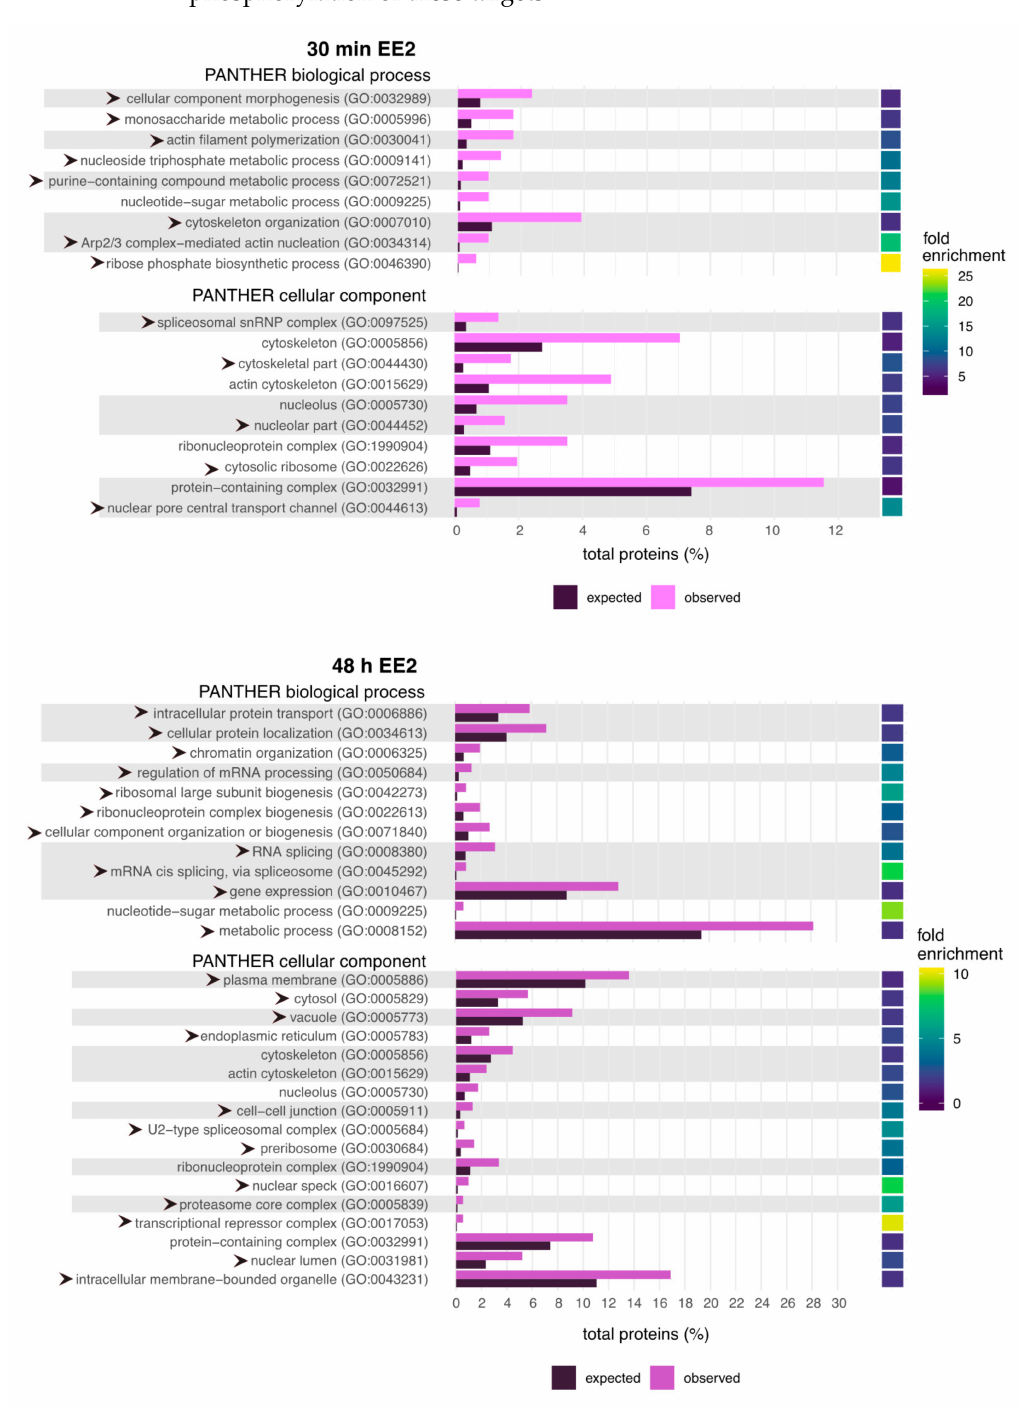
Figure 4. PANTHER Gene Ontology (GO) terms significantly enriched in the proteome following 30 min or 48 h of EE2 treatment. Terms clustered together by the grey/white background indicate those related by hierarchy. The horizontal bar plot denotes the percentage total number of expected and observed proteins for PANTHER biological processes and cellular components that were significantly enriched (Fishers exact test; corresponding fold enrichment show on the far right) following either 30 min ( top ) or 48 h ( bottom ) of EE2